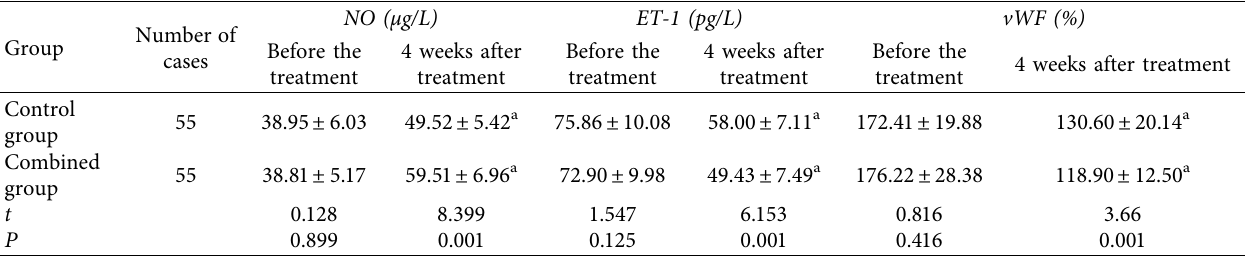
Table 4: Comparison of the vascular endothelial function between the two groups of patients ( n , x ± s ).